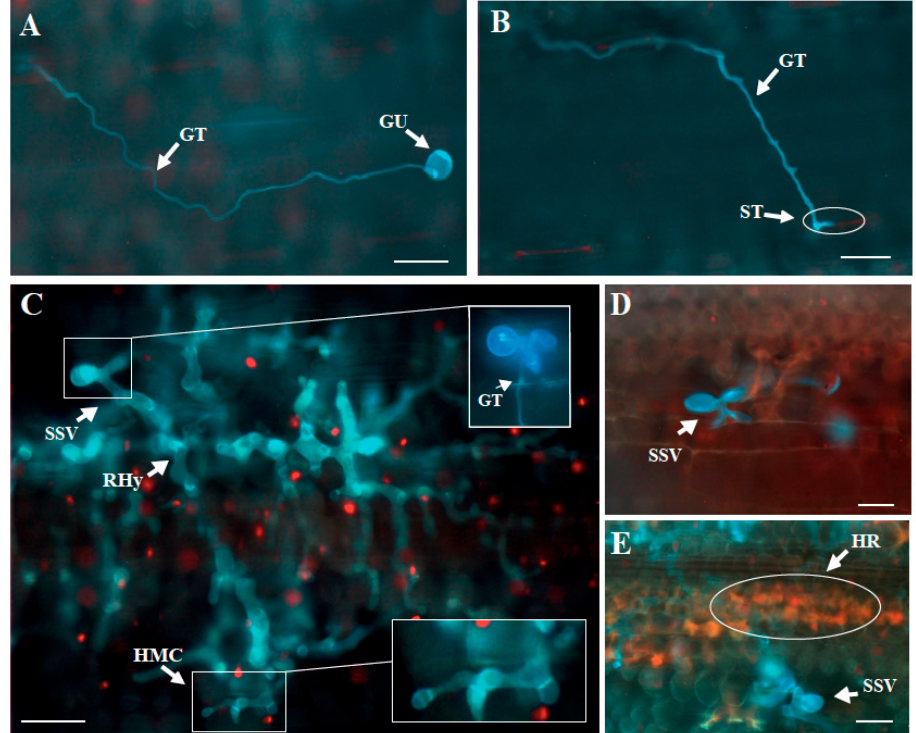
Figure 3. Microscopic fungal stages of P. striiformis and plant cellular responses were classified as: ( A ) lost germinative tube (LGT), showing the germinated urediniospore (GU) and the germinative tube (GT); ( B ) germinative tube reaching stoma (GTS), showing a germinative tube ending in a stoma (ST) without establishing a substomatal vesicle (SSV); ( C ) established microcolony without necrosis (EST–), with a detailed SSV, developing runner hyphae (RHy) and haustorial mother cells (HMC); ( D ) early ‐ aborted colony associated with hypersensitive response (EA+); ( E ) established microcolony associated with necrosis (EST+), also developing SSV with RHy and HMC associated with hypersensitive response. HR, hypersensitive response. Scale, 50 μ m.